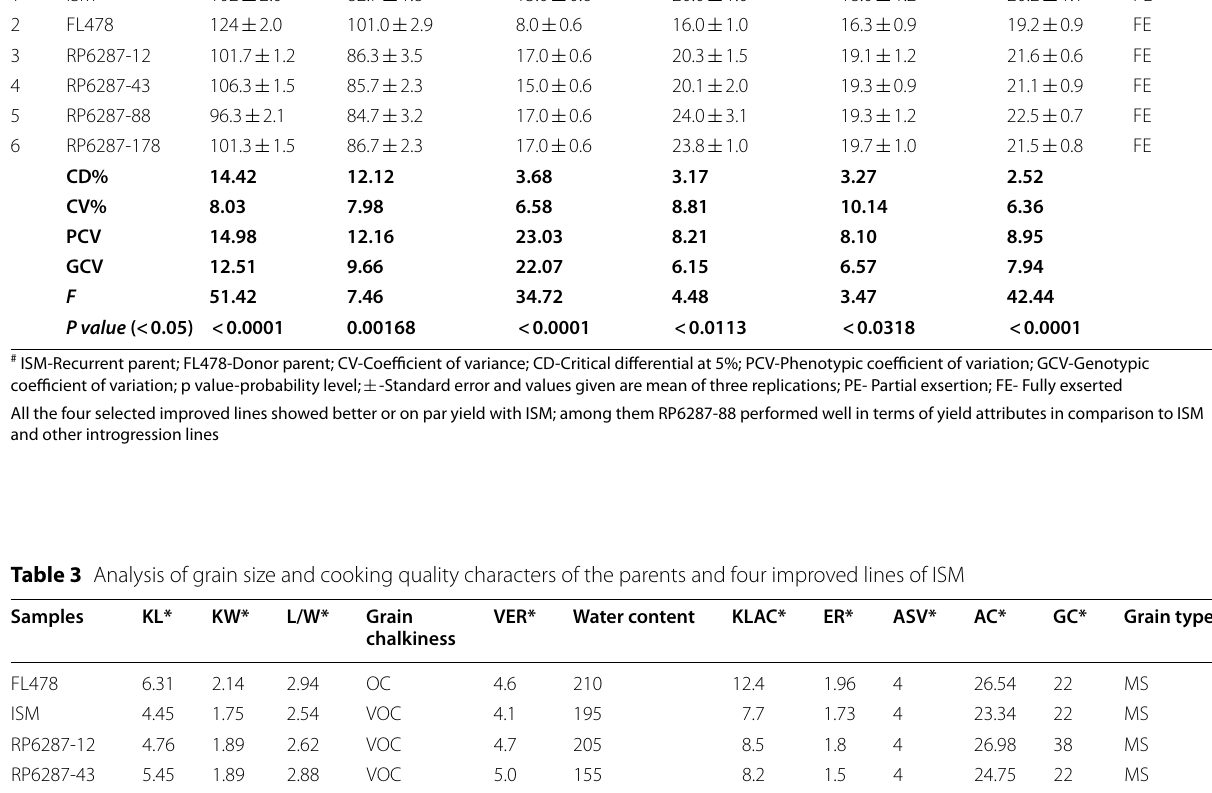
*KL- Kernel length (mm), KW- Kernel width (mm), length to width ratio, VER-Volume expansion ratio, KLAC- Kernel length after cooking (mm), ER-Elongation ratio, ASV-Alkali Spreading Value, AC-Amylose content (%), GC-Gel consistency (mm), VOC-Very Occasionally Present, OC-Occasionally present, MS- Medium